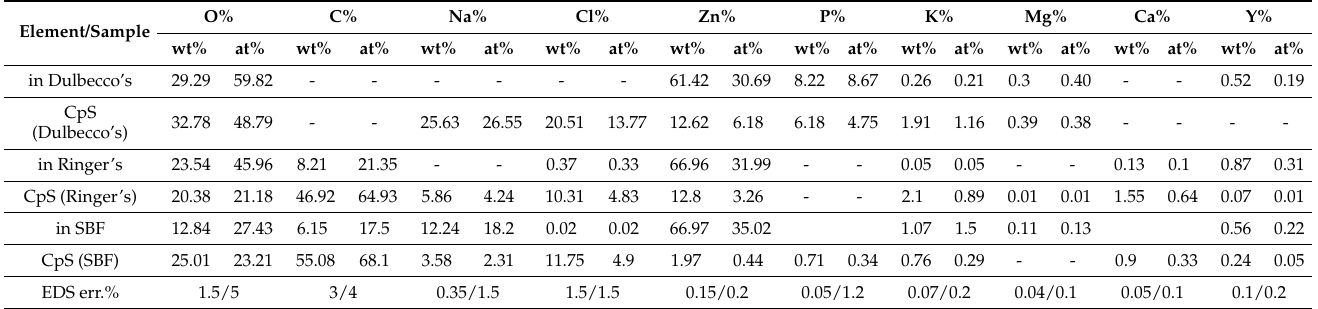
Table 4. Chemical composition (EDS detector determination using element list mode) for the al- loys’ surfaces after immersion in the tested solutions (Dulbecco’s, Ringer’s, and SBF) and for the compounds that passed into the